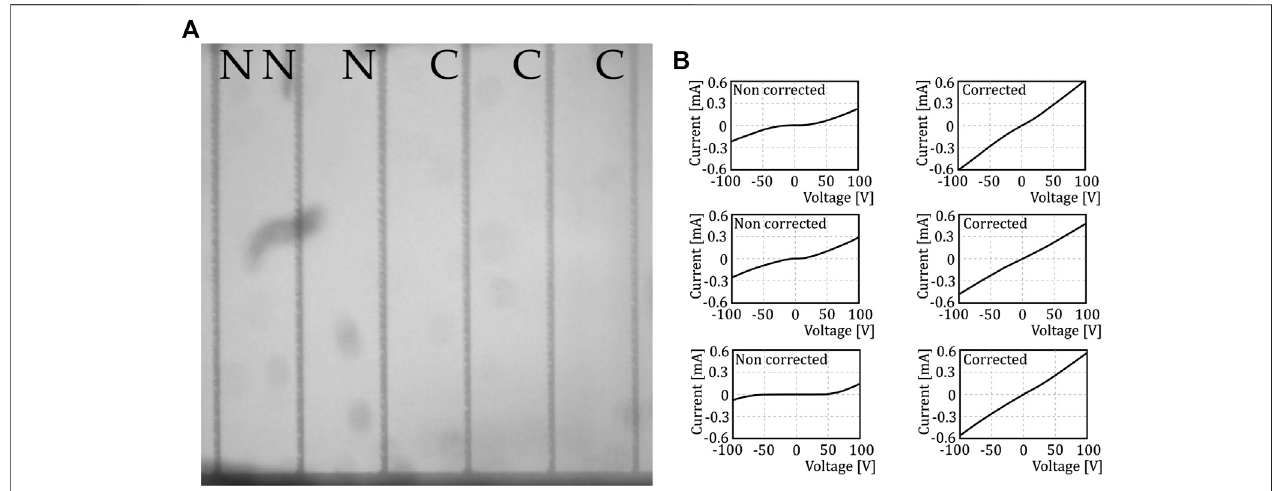
FIGURE 6 | (A) A set of piercing columns with a pitch of 100 μ m with (C) and without (N) correction, at threshold energy. (B) I-V curves for the piercing columns obtained with and without the optical correction.